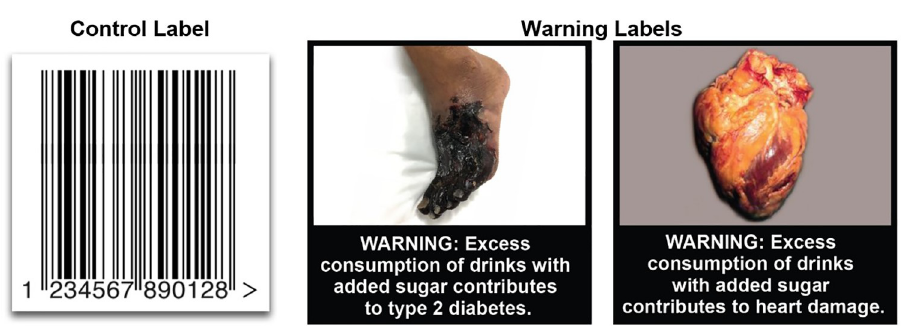
Fig 1. Study stimuli in a trial evaluating pictorial health warnings for sugary drinks.